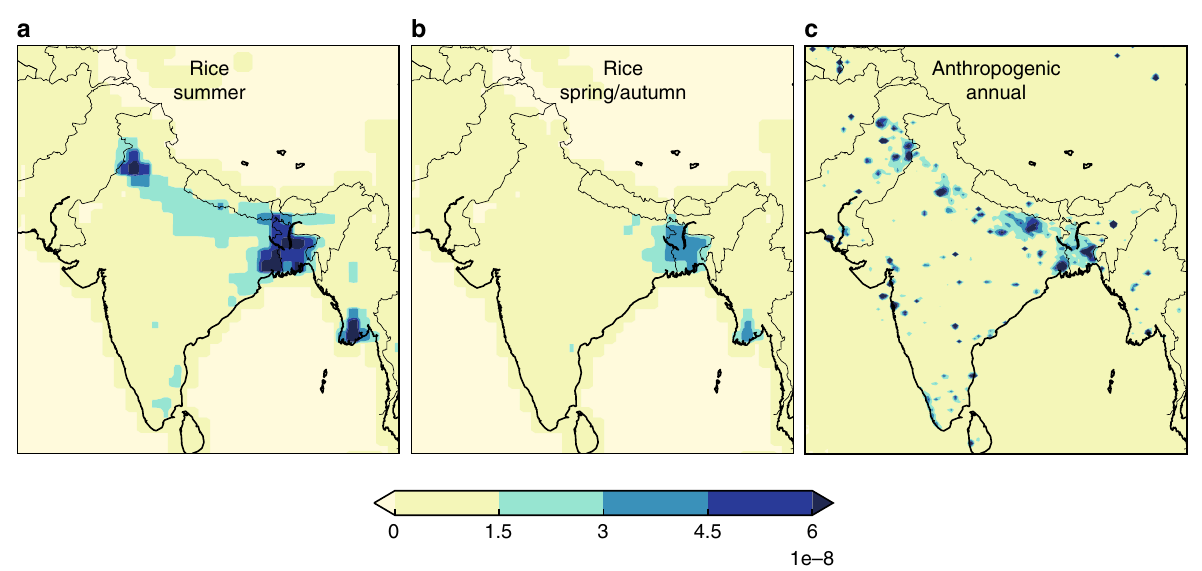
Fig. 3 Prior emissions in g m − 2 s − 1 by source sector. a Yan et al. 17 average rice emissions for June – September. b Yan et al. 17 , average rice emissions for March – May and October – December. c EDGAR v4.2FT2010 anthropogenic emissions excluding rice and ruminants (diffuse